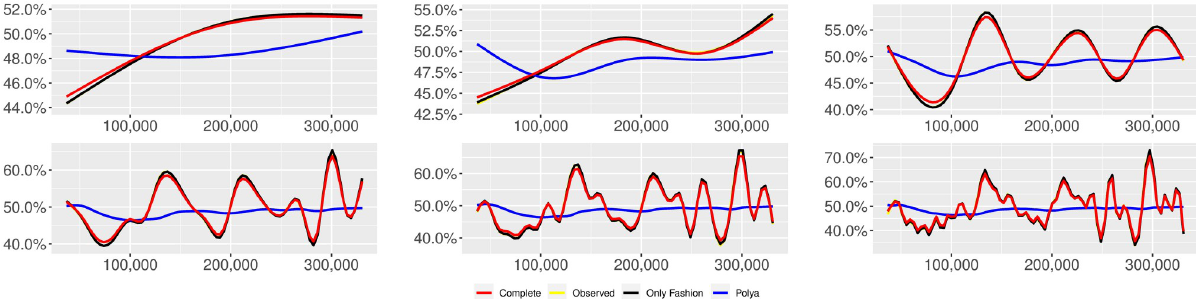
Fig 1. “Migration” ( T = 0.35, entire, D = 3 0 , S = 100 slots of equal size): Sentiment curves. In each panel, the yellow line is the cubic spline smoothing of the time series of the observed tweets ξ n +1 , together with the default confidence interval (gray), the red line represents the cubic spline smoothing of the time series of the estimated predictive means ^ c (defined in Subsec. 3.2), obtained with the complete RP model, the black and the blue lines provide n similar approximations obtained with the other models: black = Only fashion RP model and blue = Standard Po´lya model. In each panel, the smoothing is obtained with a given number of nodes: k = 3 (top left panel), 5 (top middle panel), 10 (top right panel), 20 (bottom left panel), 30 (bottom middle panel), 50 (bottom right panel).